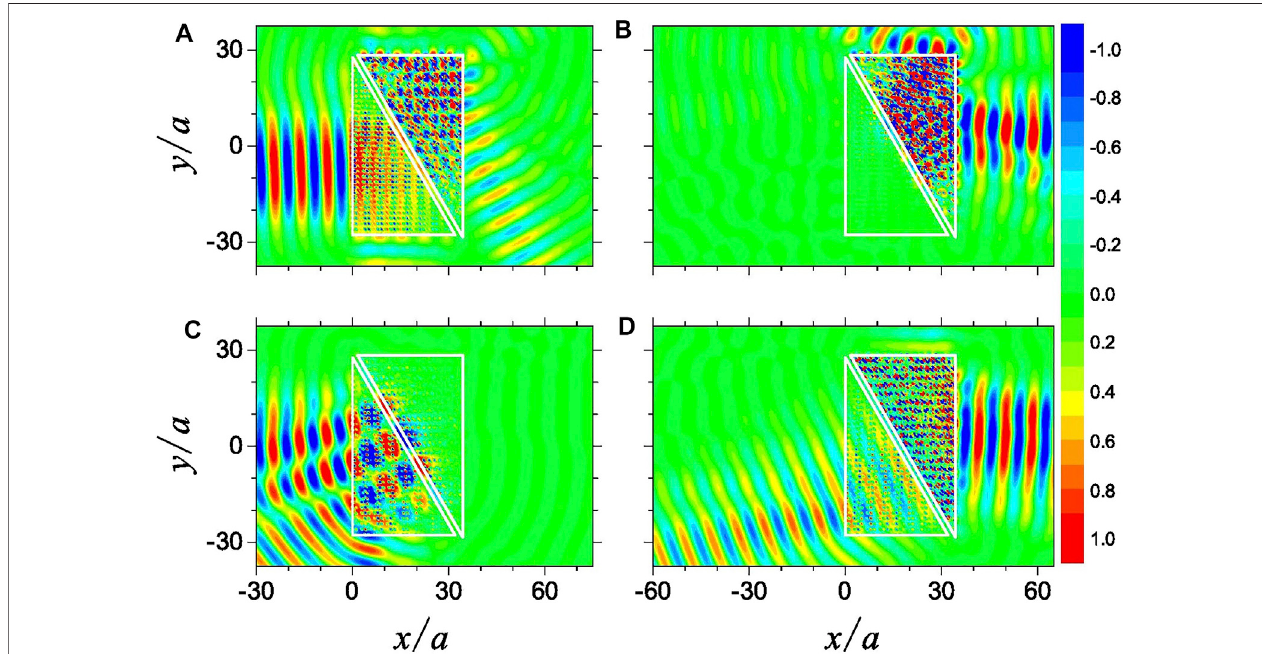
FIGURE 5 | Electric fi eld patterns illustrating the recon fi gurable unidirectional propagation by the HSMM made up of the EZI and ENI with the LHS incidence exhibiting the “ passing ” state (A) , but the RHS incidence exhibiting total re fl ection (B) . By decreasing the bias magnetic fi eld from H 1 0 (cid:1) 497 Oe to H 2 0 (cid:1) 480 Oe, the HSMM is transformed into that made up of the EZI and EPI and the “ RHS passing ” state can be observed from the fi eld patterns in panels (C,D) . For the left part of the HSMM,thelatticeseparationis ~